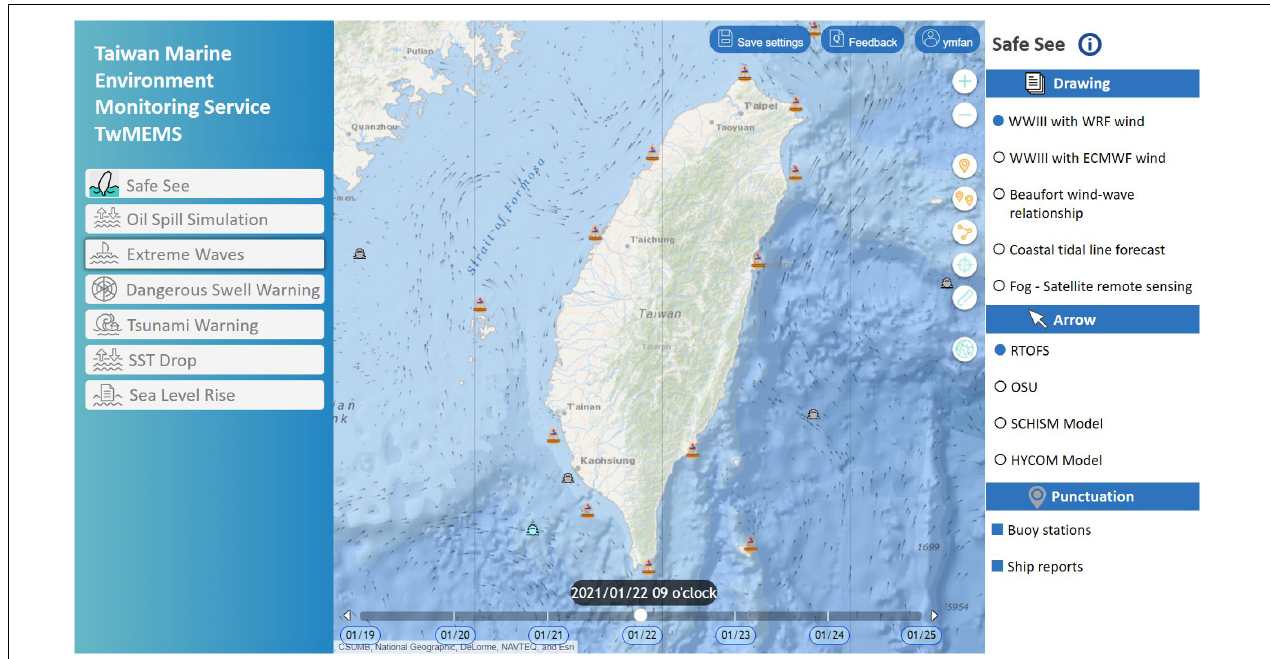
FIGURE 2 | Main page of TwMEMS (TwMEMS is a Chinese language system. For international publication, part of the pages is translated to English).